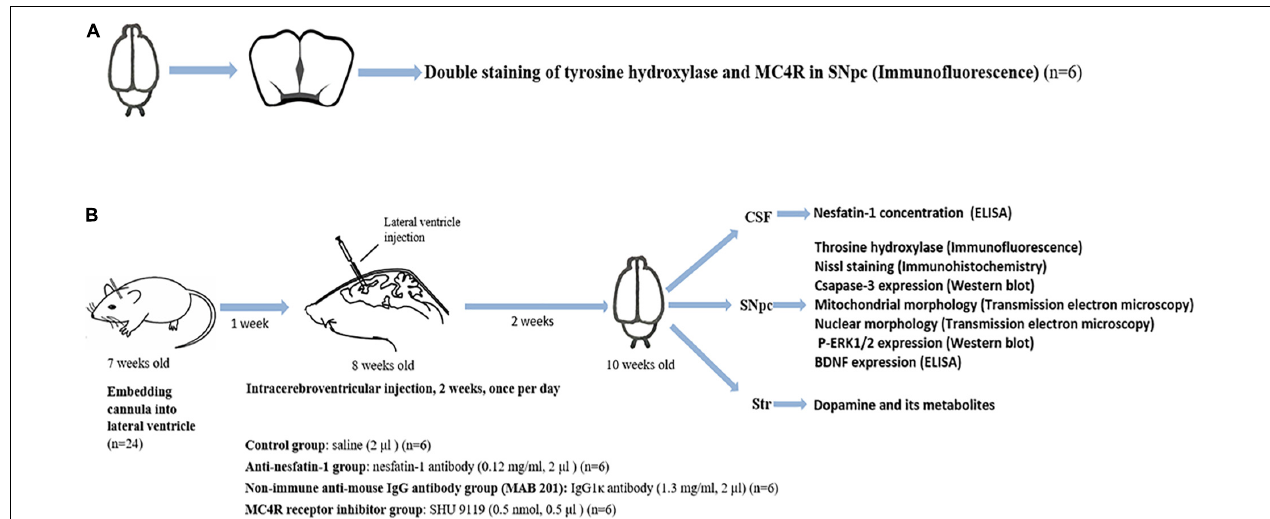
FIGURE 1 | Schematic illustration of the experimental design. (A) Double staining of TH and MC4R in the SNpc to demonstrate the presence of MC4R in the SNpc ( n = 6). (B) Anti-nesfatin-1 antibody induces nigrostriatal system degeneration in mice ( n = 24, six mice per group). The mice received the substances at the doses indicated by ICV injection for 14 days. The CSF was collected for the determination of the nesfatin-1 concentration. The SNpc and striatum were collected for the determination of TH, caspase-3, and p -ERK1/2 expression, BDNF concentration, mitochondrial morphology, and nuclear morphology. BDNF, brain-derived neurotrophic factor; CSF, cerebrospinal fluid; ELISA, enzyme-linked immunosorbent assay; MAB 201, non-immune anti-mouse IgG antibody; MC4R, melanocortin 4 receptor; p -ERK1/2, phosphorylated ERK1/2; SHU 9119, MC4R receptor inhibitor; SNpc, substantia nigra pars compacta; Str, striatum; TH, tyrosine hydroxylase; ICV,